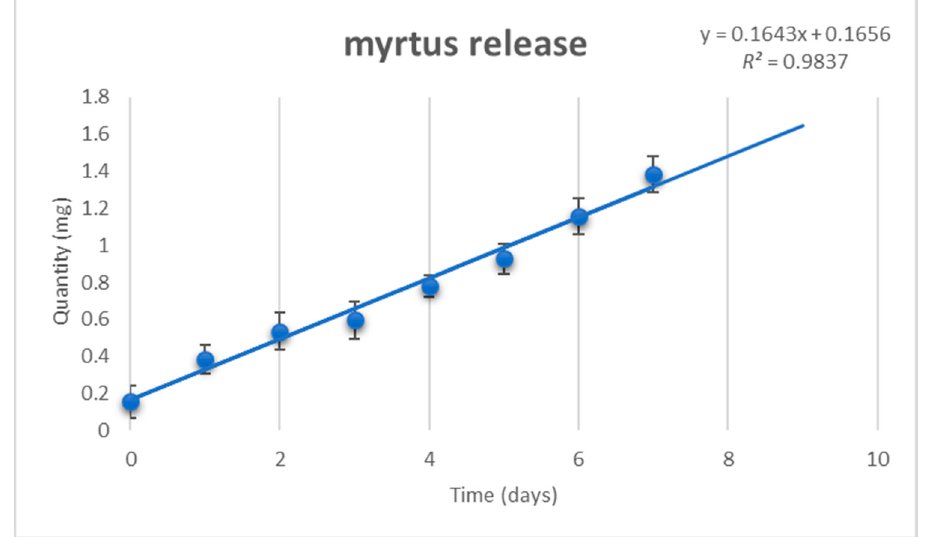
Figure 3. Release of myrtle extracts from NanoPCL-M for seven days. The amount of extracts is evaluated as absorbance OD detected at 405 nm, and expressed as mg/day. Error bars indicated standard deviation of the experiments ( n = 6).